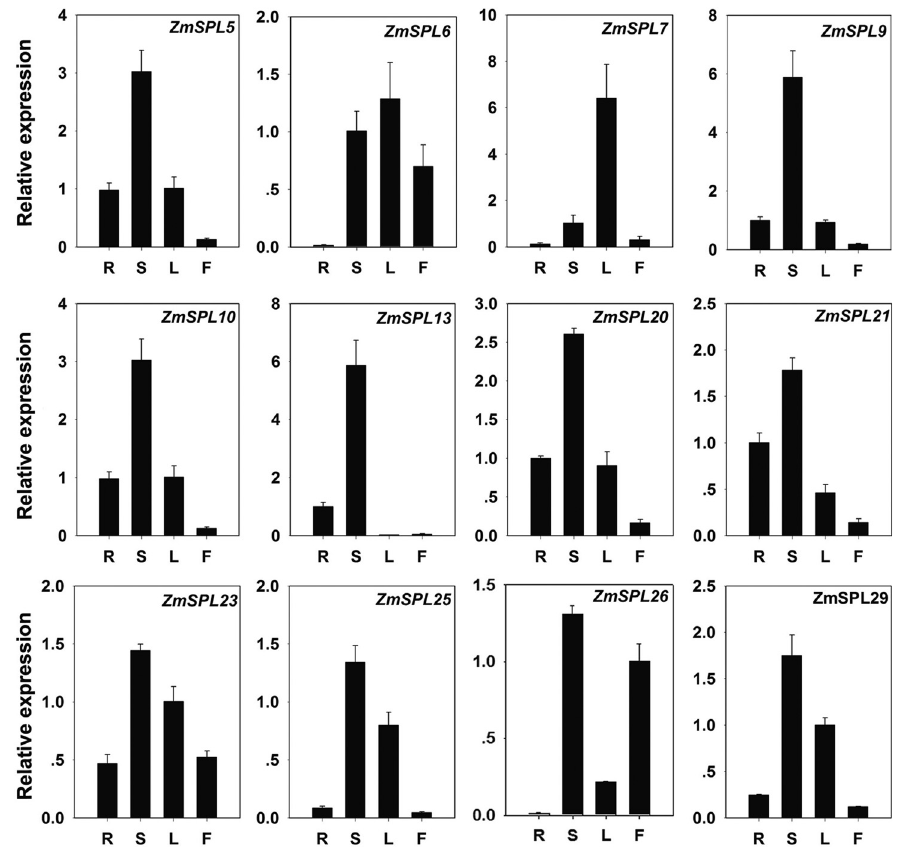
Figure8 -Expressionpatternsof12miR156targeted ZmSPLs infourrepresentativetissues.R:root;S:stem;L:leaf;F:filament.Shownaremeans (cid:5)